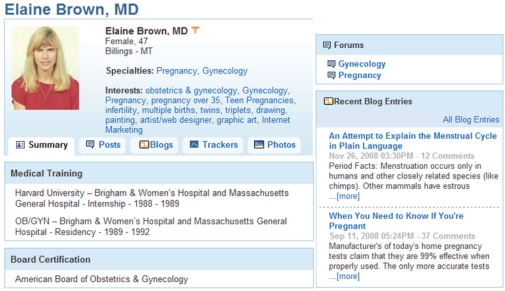
Example of a MedHelp physician homepage.